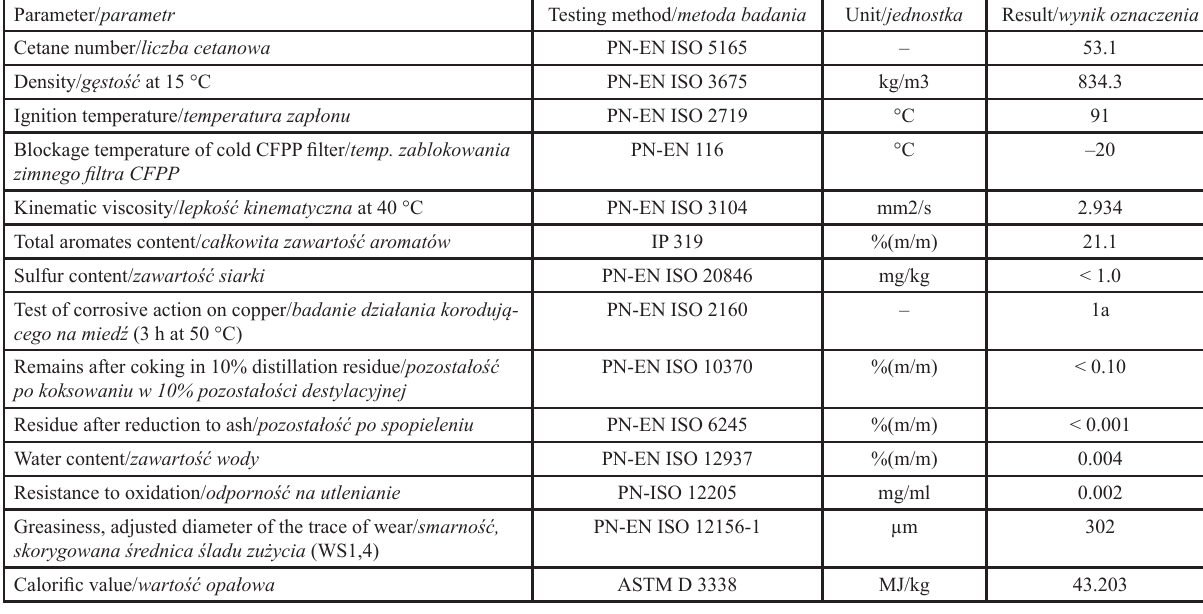
Table 1. Physicochemical properties of the CEC DF-79-07/7